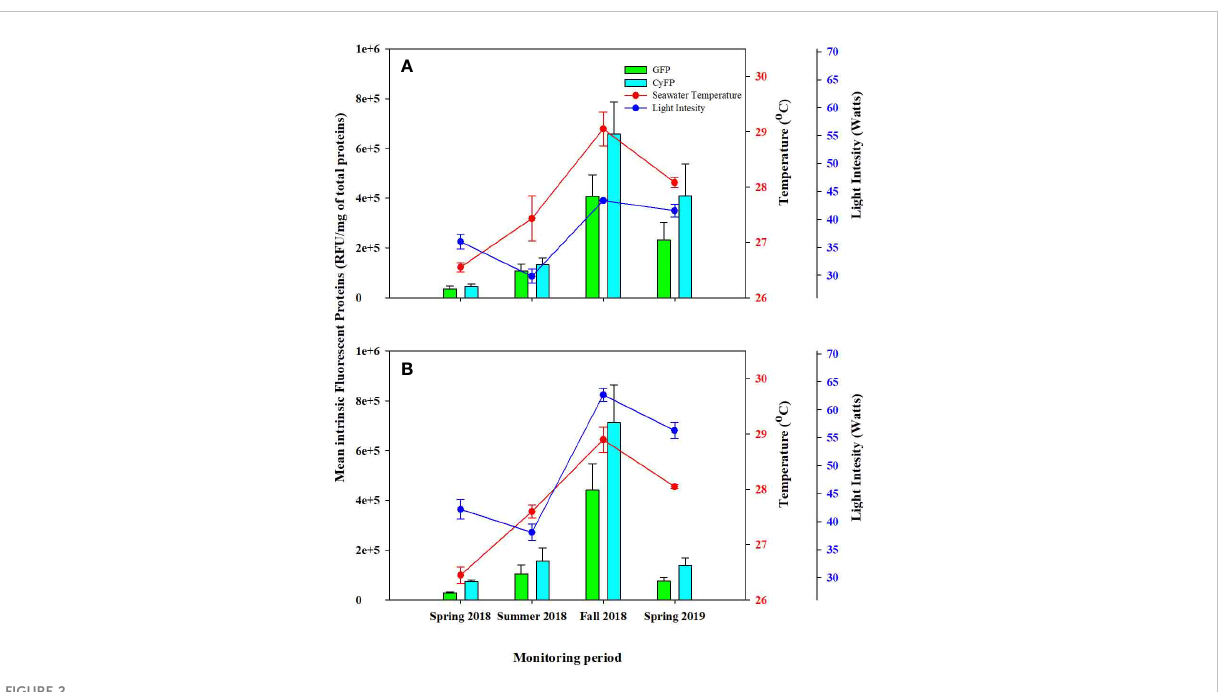
FIGURE 2 Comparison between Green Fluorescent (GFP) and Cyan Fluorescent Protein (CyFP) for control colonies across survey periods. (A) Control colonies from deep water farms (DD) and (B) control colonies from shallow water farms (SS). Red and blue dots represent seawater temperature and light intensity respectively; Green bars represent GFP and Cyan bars represent CyFP; whiskers represent standard error.